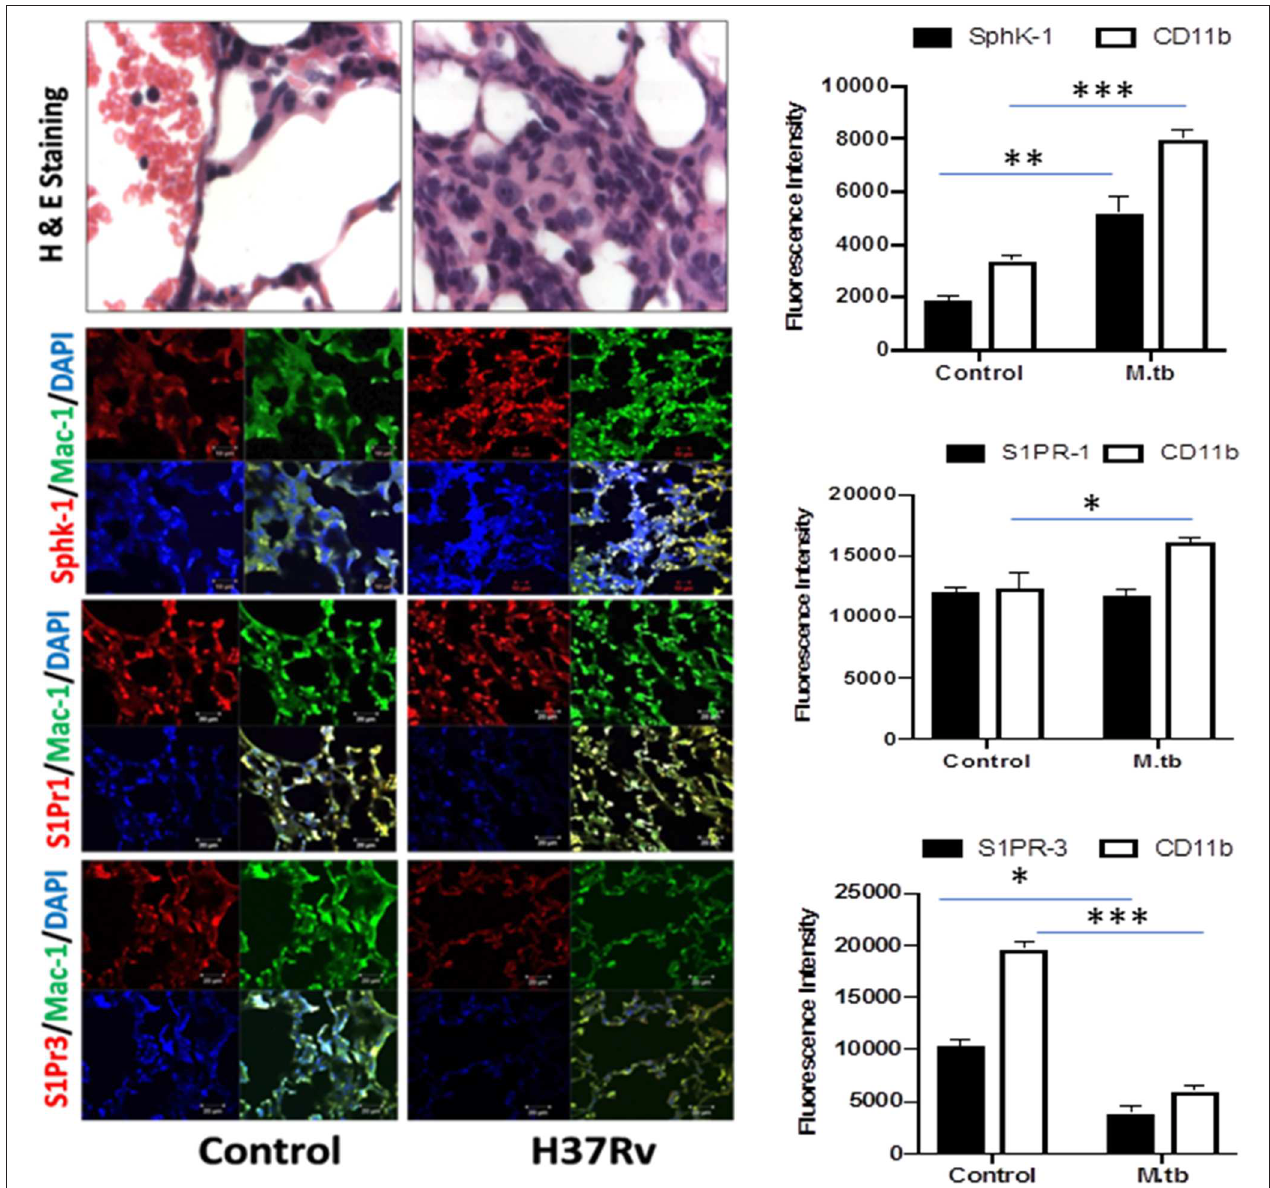
FIGURE 5 | Increased infiltration of macrophages into the lung of M. tuberculosis –challenged animals. Sections of lungs from infected mice were analyzed for expression of sphingosine-1-phosphate receptor (S-1PR)1, S-1PR3, and SphK-1 and infiltration of CD11b + macrophages by confocal microscopy. Shown here is the representative images of mouse lung from each group. Mean fluorescence intensities of Sphk-1, S-1PR1, and S-1PR3 expression were plotted against Mac1 expression. Statistical analyses were conducted using two-way ANOVA followed by Bonferroni posttest (* P < 0.05, ** P < 0.01, *** P <